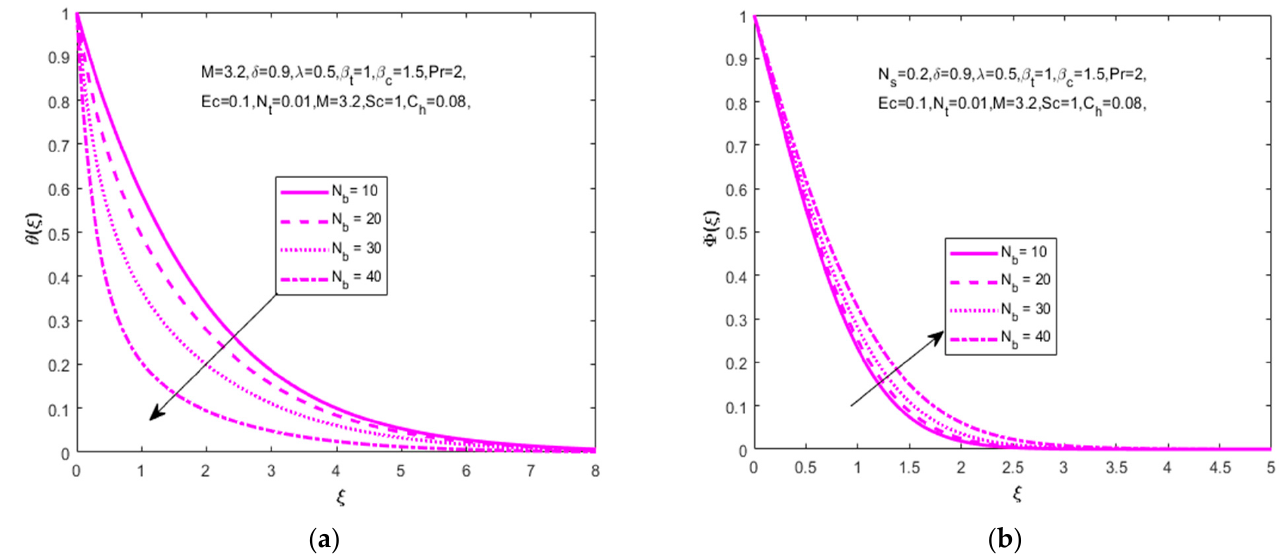
N on ( a ) temperature ( ( )) θ ξ and ( b ) concen- b